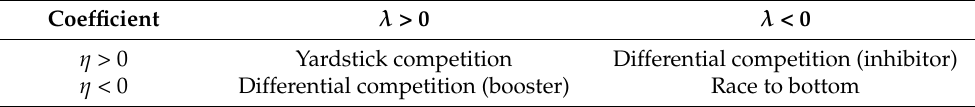
Table 1. Identification of environmental regulation policy competition